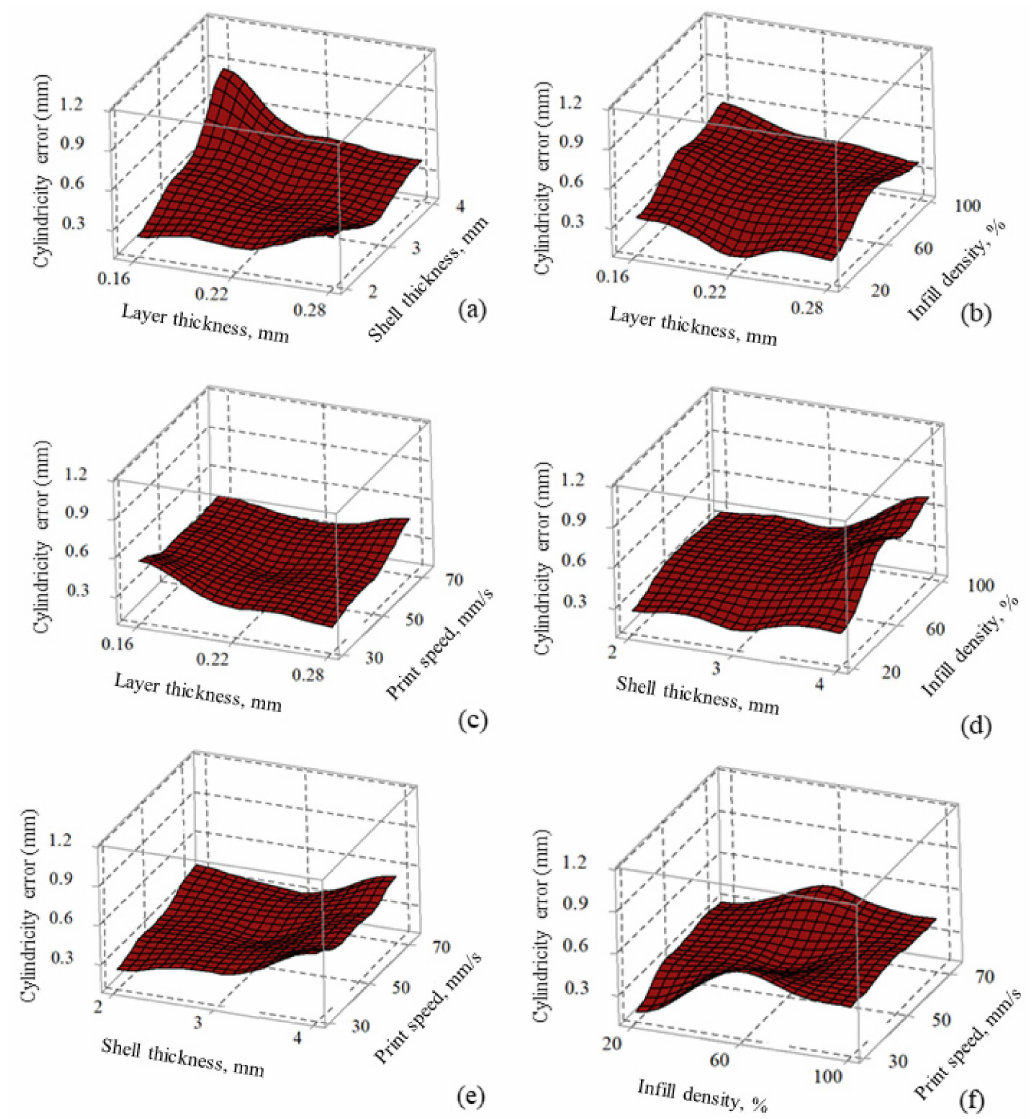
Figure 4. Surface plots of cylindricity error vs. ( a ) LT and ST, ( b ) LT and ID, ( c ) LT and PS, ( d ) ST and ID, ( e ) ST and PS, and ( f ) ID and